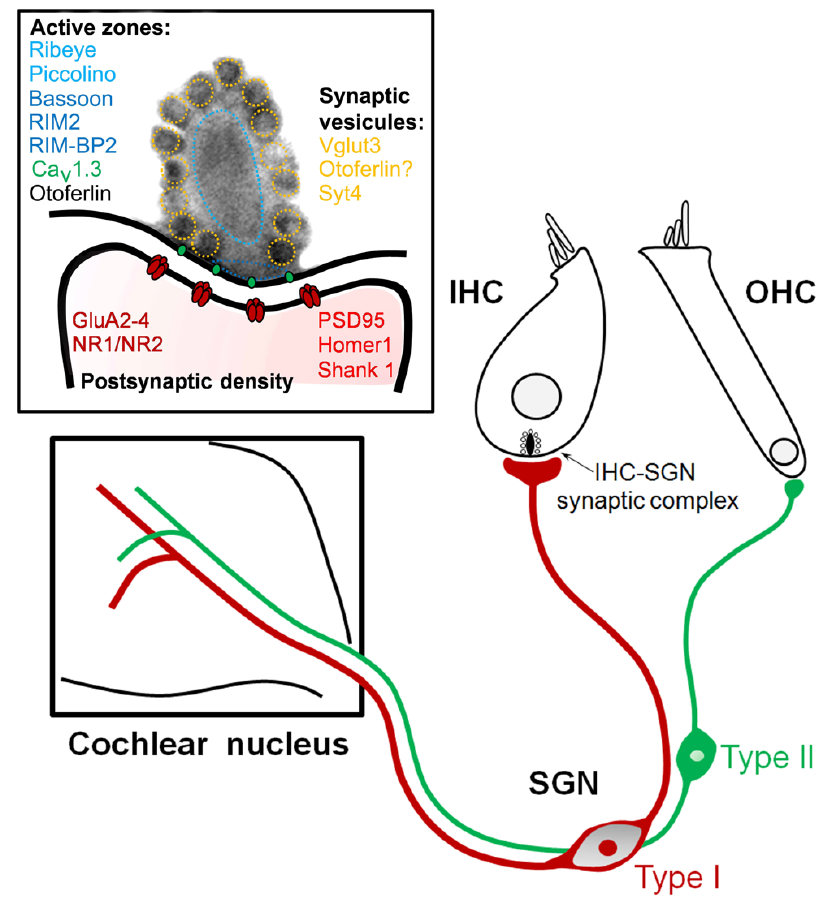
Figure 1. Inner hair cell (IHC)–spiral ganglion synaptic complex. The IHC is connected to all type I spiral ganglion neurons (SGNs) forming the radial afferent system (red) going to the cochlear nuclei. The OHC synapses with small endings from type II spiral ganglion neurons, forming the spiral afferent system (green). Molecular composition of a mature ribbon of the inner hair–cell synaptic complex ensuring the temporal precision of peripheral sound encoding. The mature ribbon synapse between the sensory inner hair cells (IHCs) and postsynaptic spiral ganglion neurons (SGNs) involves the spatial confinement of several molecular components: presynaptic density merge to one single ribbon anchor and, postsynaptically, one continuous elongated postsynaptic density composed by functional synaptic AMPA-preferring glutamate receptors, but also some silent NMDA receptors. Font color indicates association with the correspondingly colored pre-/postsynaptic localization.